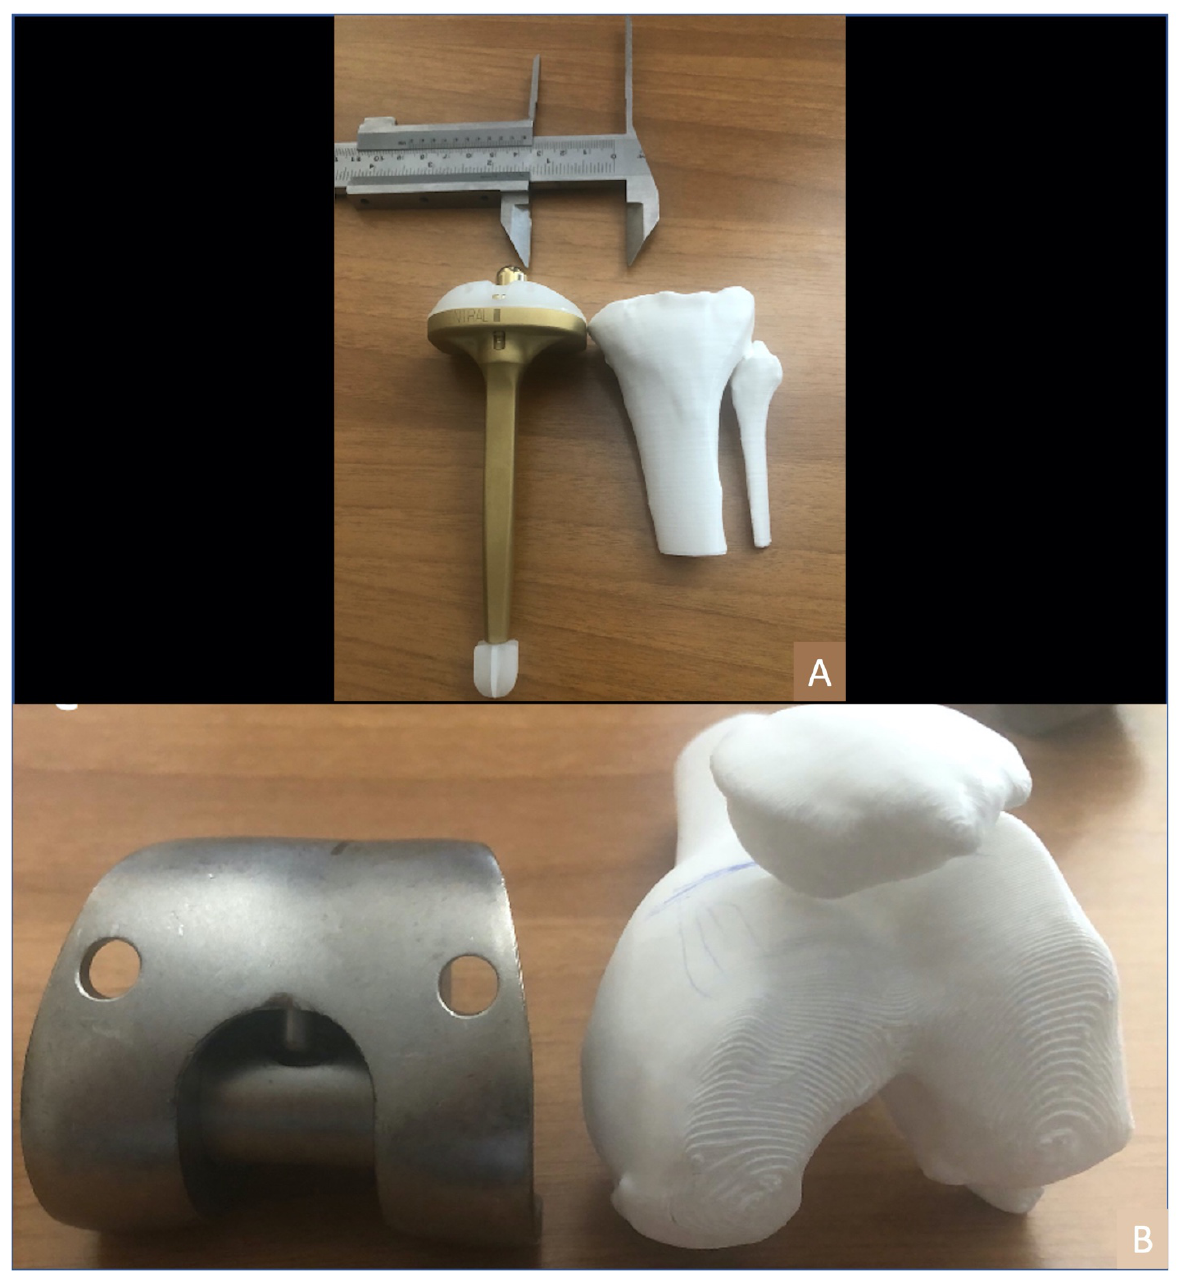
Figure 4. Three-dimensionally-printed model for pre-operative planning and implant size evalua- tion. ( A ) Comparison between tibial component size and tibial bone model; ( B ) comparison between femoral component size and femoral bone model.